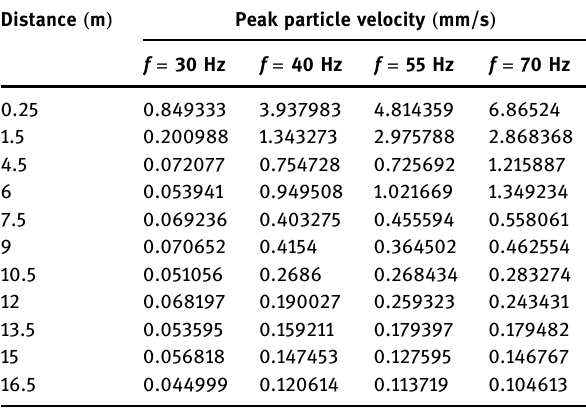
Table 10: The measured peak particle velocities at di ff erent loca - tions for various frequencies ( active in - fi lled with 40%